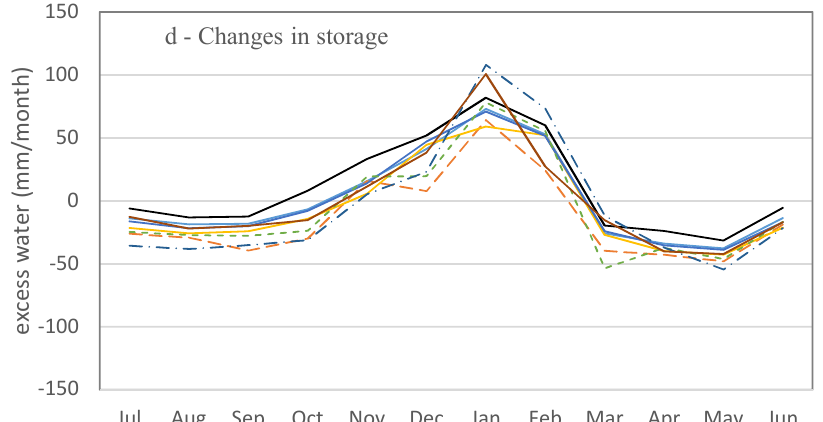
Figure 7. Monthly water balance calculations for catchments based on rainfall ( a ); runoff ( b ) and evapotranspiration ( c ) during 2000 to 2014, except for Gainsford that started in 2004. Changes in water storage ( d ) are calculated based on Equation (1) by subtracting runoff and evapotranspiration from rainfall data for each month.